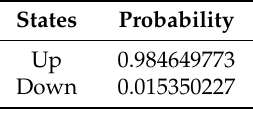
Table 3. Two-state model of a central PV system.